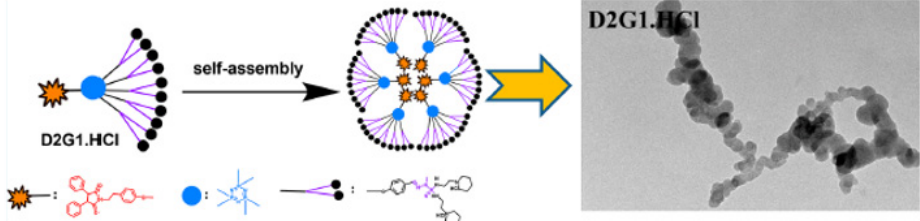
Figure 8. Self-assembly of D2G1.HCl amphiphilic dendrons to form nanostructured aggregates (micelles). Reproduced with permission from reference [39], American Chemical Society.